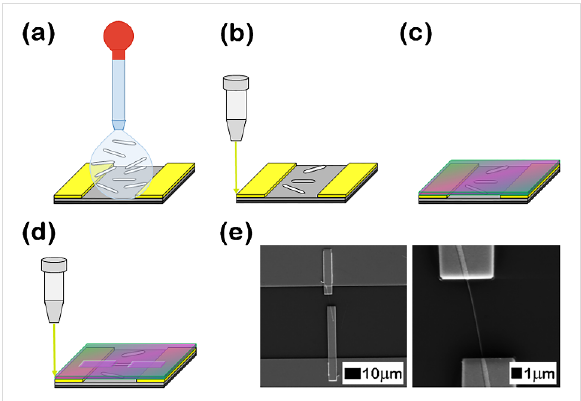
Figure 8: (a) Ni–Cu alloy nanowires placed on SiO2/Si substrates be- tween the interdigitated metallic electrodes obtained by photolithog- raphy; (b) alignment of the SiO 2 /Si substrate with the sample holder of the microscope; (c) the sample covered with a poly(methyl methacry- late) film deposited by spin coating; (d) irradiation of the polymer layer for contacting the ends of the nanowire with the interdigitated metallic electrode; (e) SEM images of a single Ni–Cu alloy nanowire contacted using